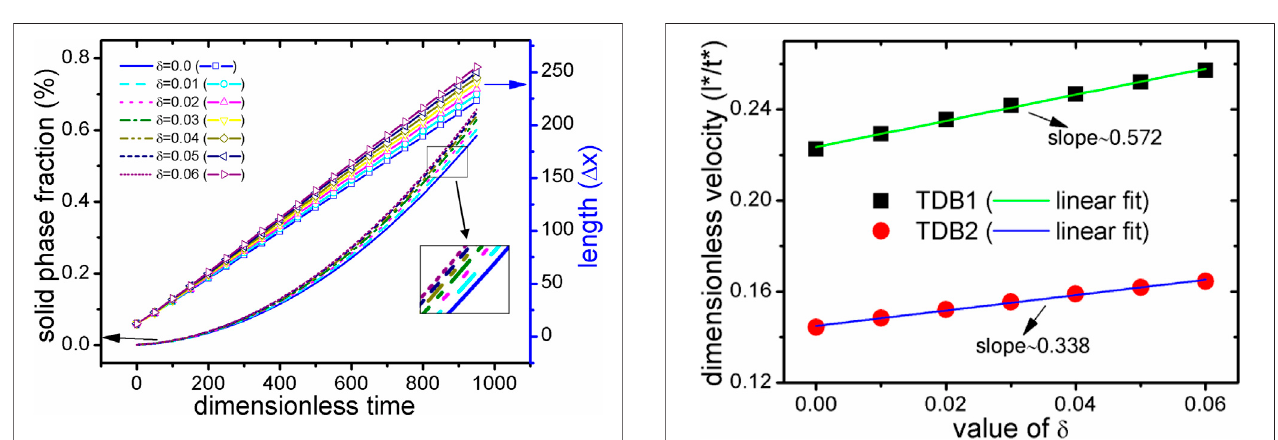
FIGURE 7 | During the solidi fi cation process at 1800 K, the relationship between the main radius velocity of the solid phase and the anisotropic strength δ .TheblacksquarerepresentsforTDB1,andtheredcircleforTDB2. The straight lines are their linear fi tting lines. l * and t * denote the dimensionless length and time,